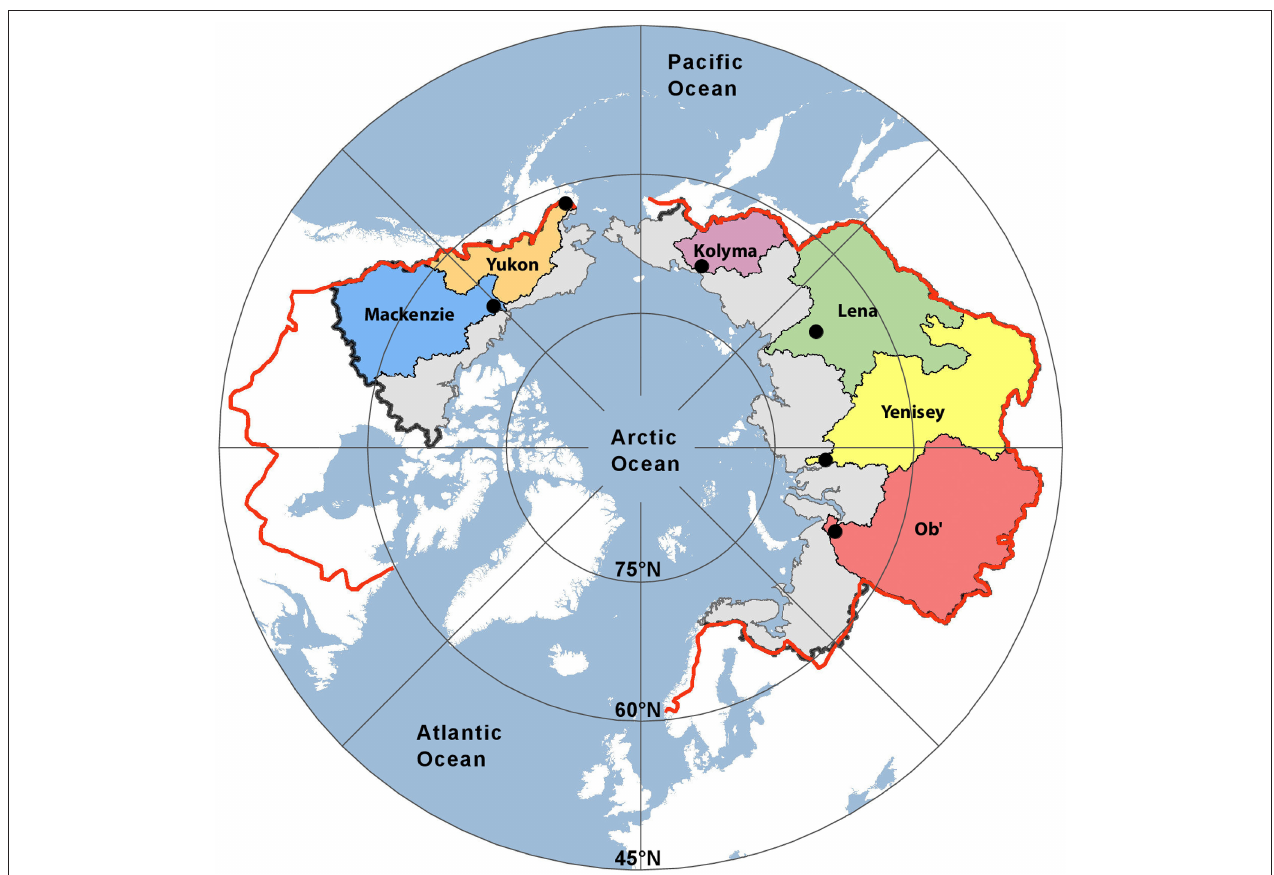
FIGURE 1 | Map showing the six Arctic river catchments sampled. Black dots indicate sampling locations. The black (PA1) and red lines (PA2) represent two estimates of the total pan-arctic watershed area ( 16.8 × 10 6 km 2 and 20.5 × 10 6 km 2 , respectively).